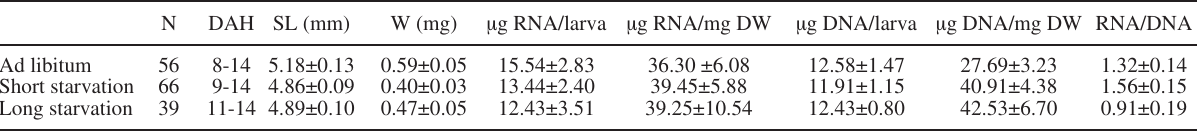
Table 1. – Number of larvae, age range, mean size (±SE) and mean nucleic acid content of analyzed larvae (±SE) in the three feeding treat- ments. N = number of larvae, DAH = days after hatching, SL = standard length, W = weight, DW = dry weight, SE = standard